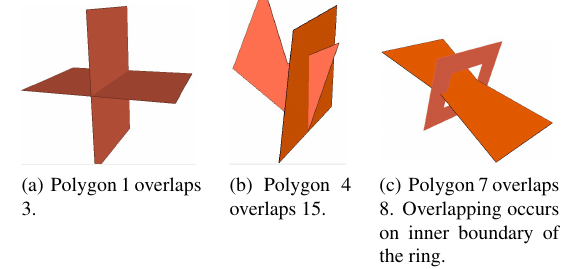
Figure 11: Polygon pairs whose topological relationships are cal- culated as ’overlap’.